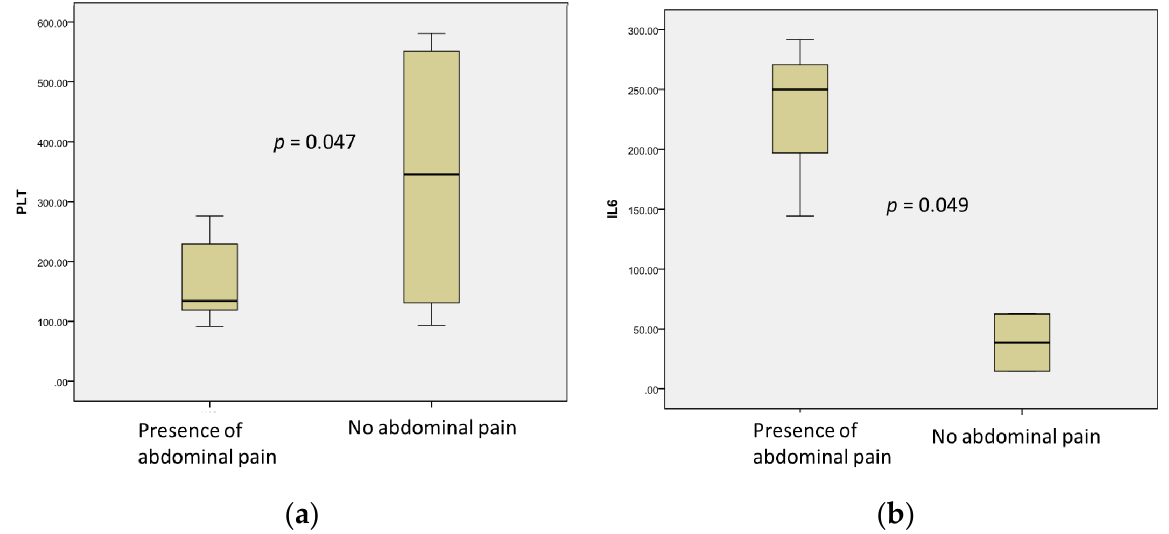
Figure 3. Association of abdominal pain with low platelet counts ( a ), n = 19; and elevated levels of IL-6 ( b ), n = 9. Conjunctival injections and periorbital edema correlated with elevated GGT levels (222.00 ± 10.43 vs. 33.33 ± 19.76, p = 0.014) and maximal fever (38.00 vs. 39.00 p = 0.022). Moreover, skin rash was observed more frequently in patients with a lack of lymphope- nia (0.62 ± 0.30 vs. 1.26 ± 0.74, p = 0.029) and a low level of LDH (316.55 ± 122.31 vs. 528.20 ± 130.81, p = 0.077) (Figure 4a,b). Ascites was associated with lymphopenia (0.86 ± 0.80 vs. 0.96 ± 0.42, p = 0.029) (Figure 4c) and elevated LDH (464.42 ± 110.83 vs. 311.50 ± 54.38, 0.077). Hepato-splenomegalia was also found more frequently in children with lymphopenia (0.5 ± 0.14 vs. 1.09 ± 0.9, p = 0.039) (Figure 4d), higher troponin I (402.00 ± 101.23 vs. 3.00 ± 2.12, p = 0.004), and low ESR (5.00 vs. 17.00 ± 1.41, p = 0.091). Five children had US evidence for enlarged mesenteric lymph nodes, nine had pleural effusion, and five pericardial reactions with small effusion. No correlation of serositis with hypoalbuminemia or other laboratory parameters was demonstrated. Three children had US, laboratory, ECG, and clinical evidence for myocardial